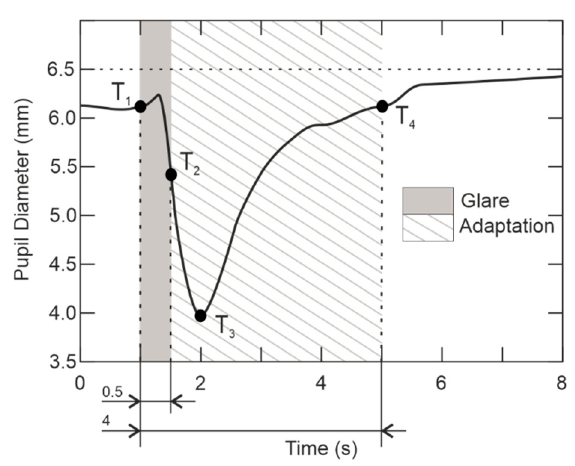
Figure 2. Accommodation response of human eyesight (adapted from [15]).